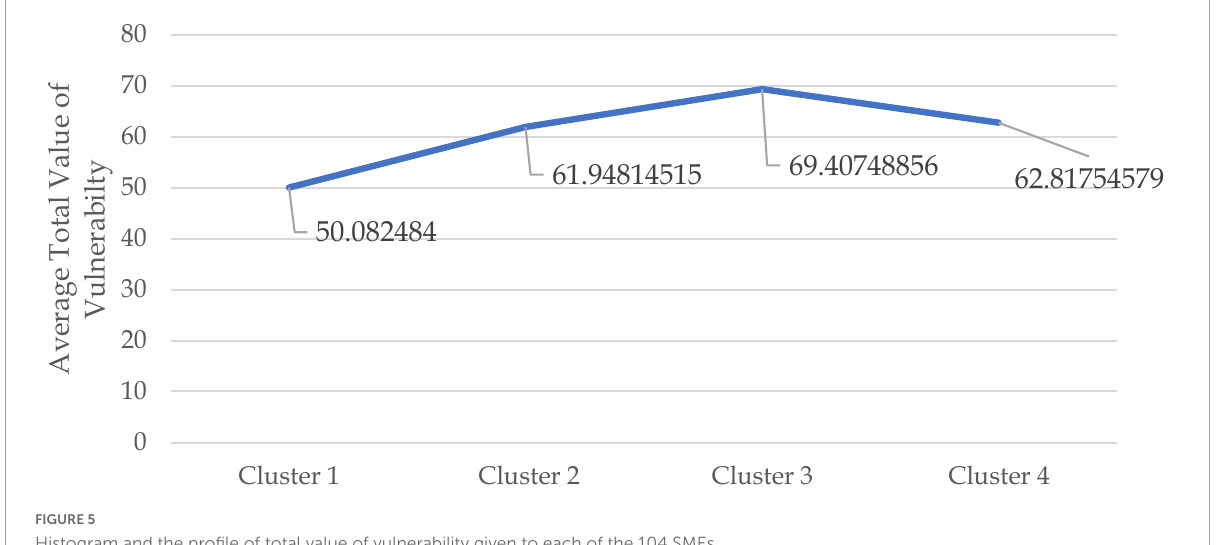
FIGURE5 Histogram and the profile of total value of vulnerability given to each of the 104 SMEs.